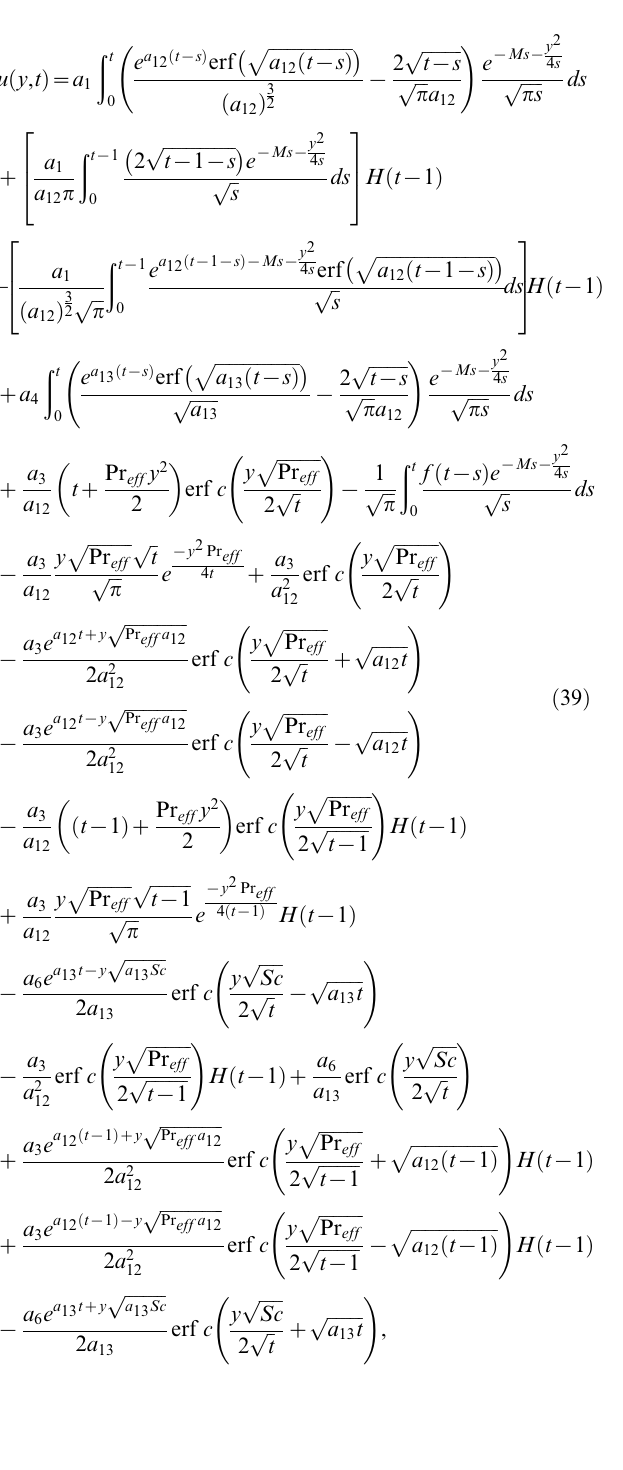
erf c erf c erf c